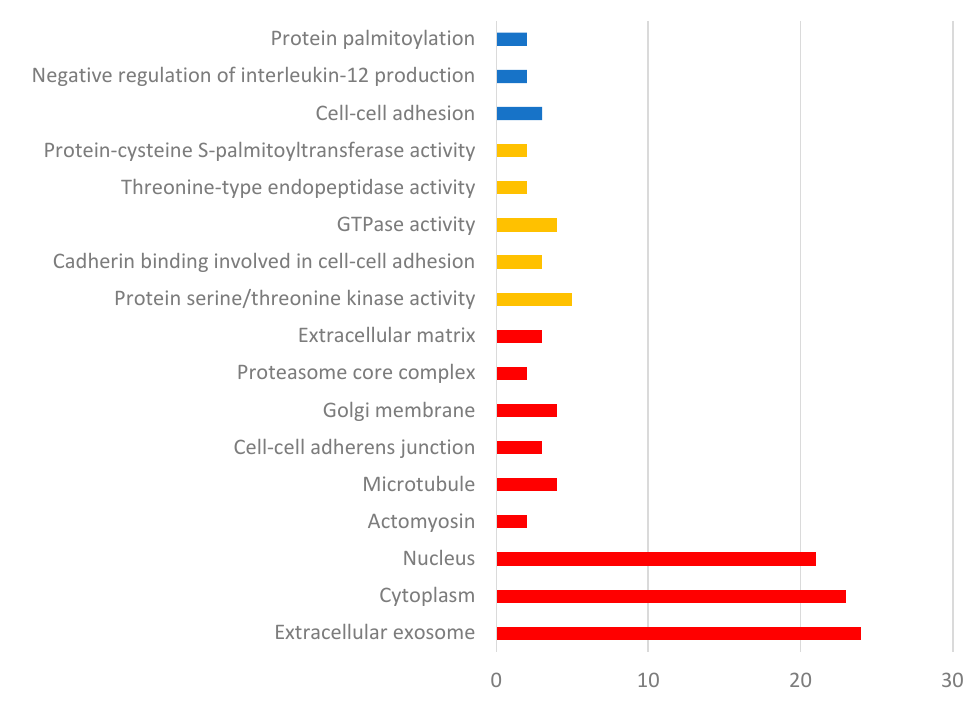
Figure 4. Biological processes (blue), molecular functions (yellow), and cellular components (red) identified by DAVID for the list of differentially expressed genes from the rumen tissue of two populations of steers with high and low RFI.